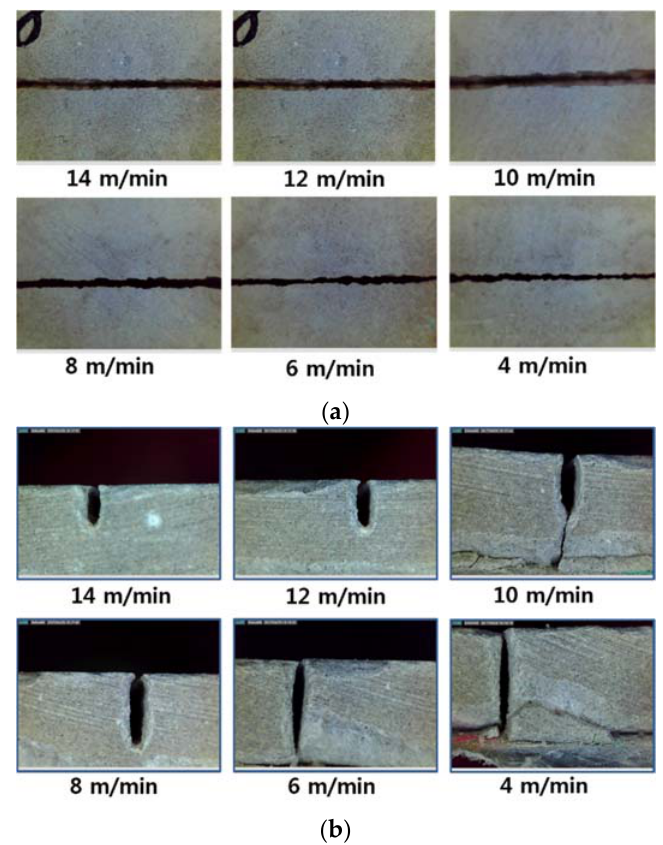
Figure 3. Kerf width ( a ) and penetration depth ( b ) vs. laser moving speed for LP0.35.